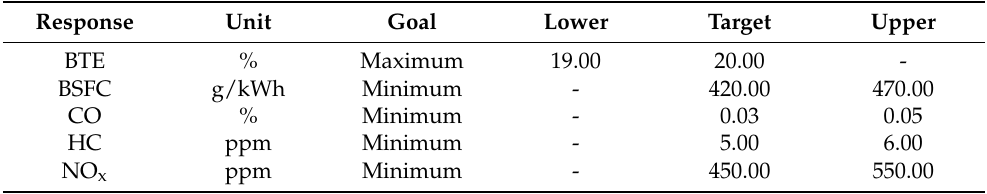
Table 8. Response optimization bounds.